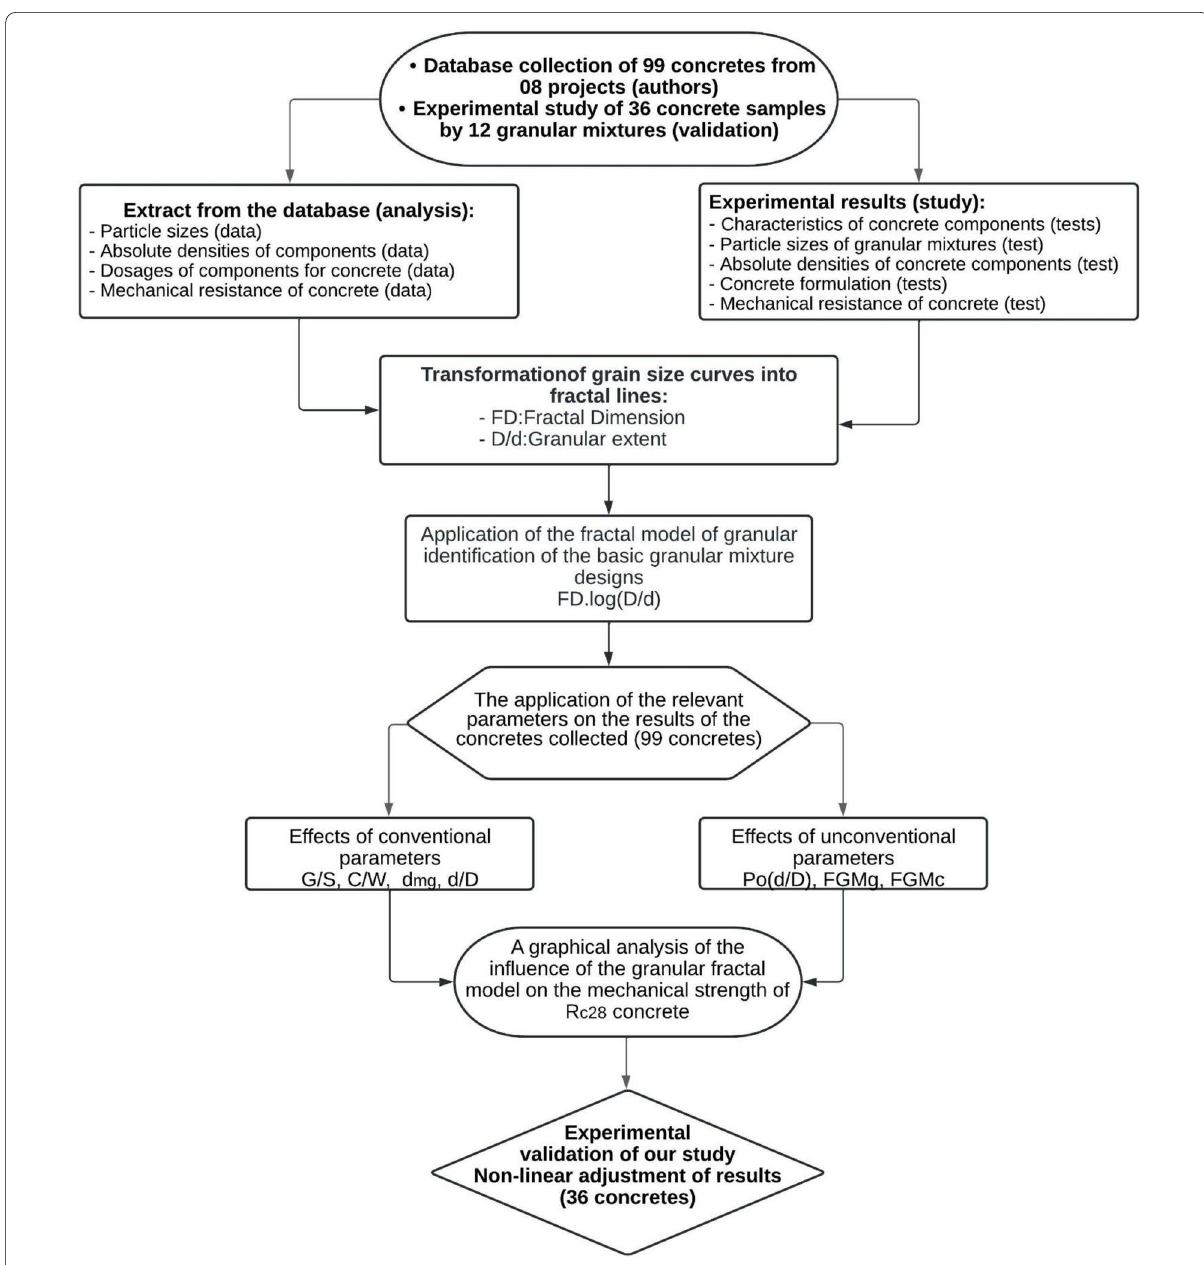
Fig. 1 Design automation diagram for the proposed approach, based on collected